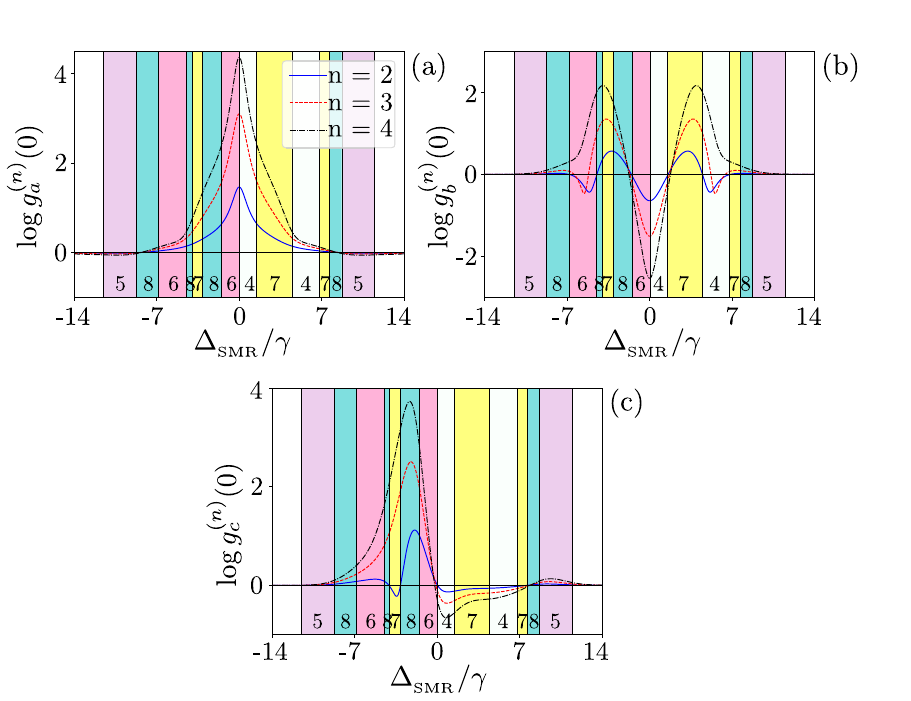
( n ) ( 0 ) of various orders [second (solid curves), third (dashed), and Figure 14. Correlation functions log g i forth (dot-dashed)] versus the detuning between the drive and SMR (in units of the qubit decay rate γ ) for the QD-driven system for: ( a ) the photonic mode a , ( b ) the phononic mode b , and ( c ) the hybrid mode c . All parameters and colourful regions are the same as in Fig.